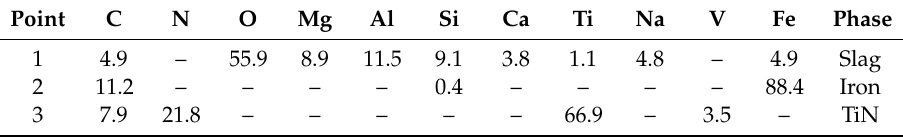
Figure 8. SEM image and elemental surface scanning image of the pellets with sodium borate reduced at 1300 °C for 90 min: ( a ) SEM image and ( b ) elemental surface scanning image. Table 3. Chemical composition of points indicated in Figure 8a (mass %).